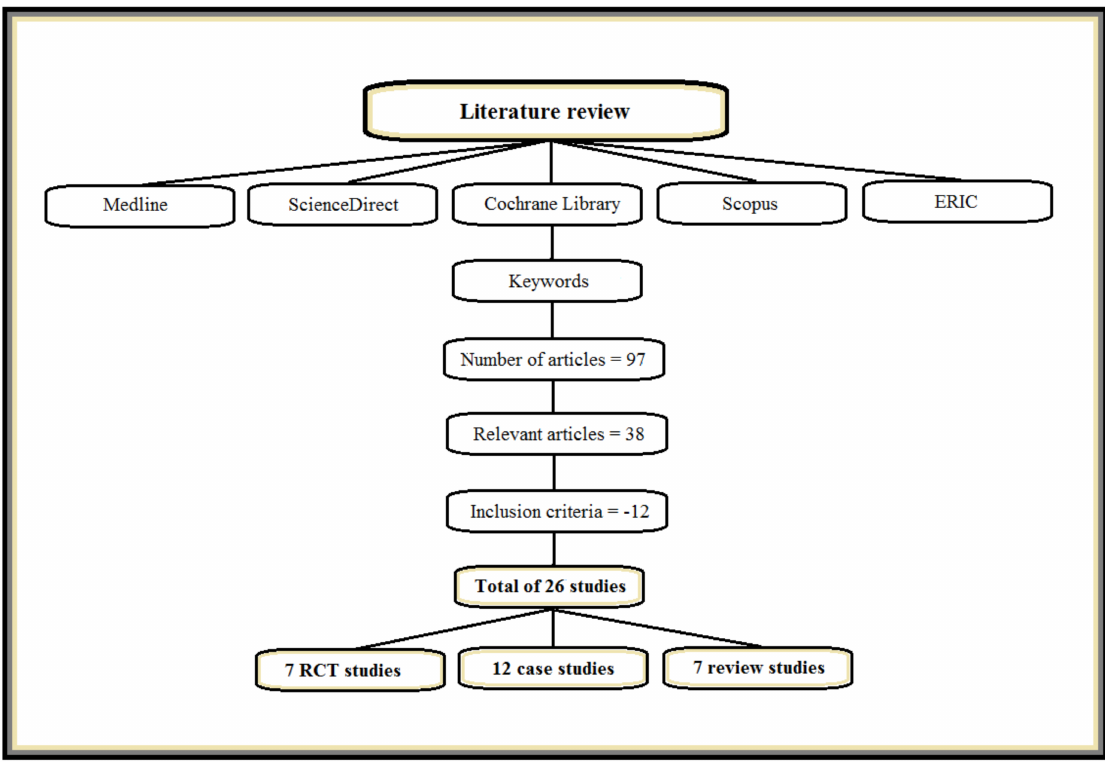
Figure 1. Overview of the study